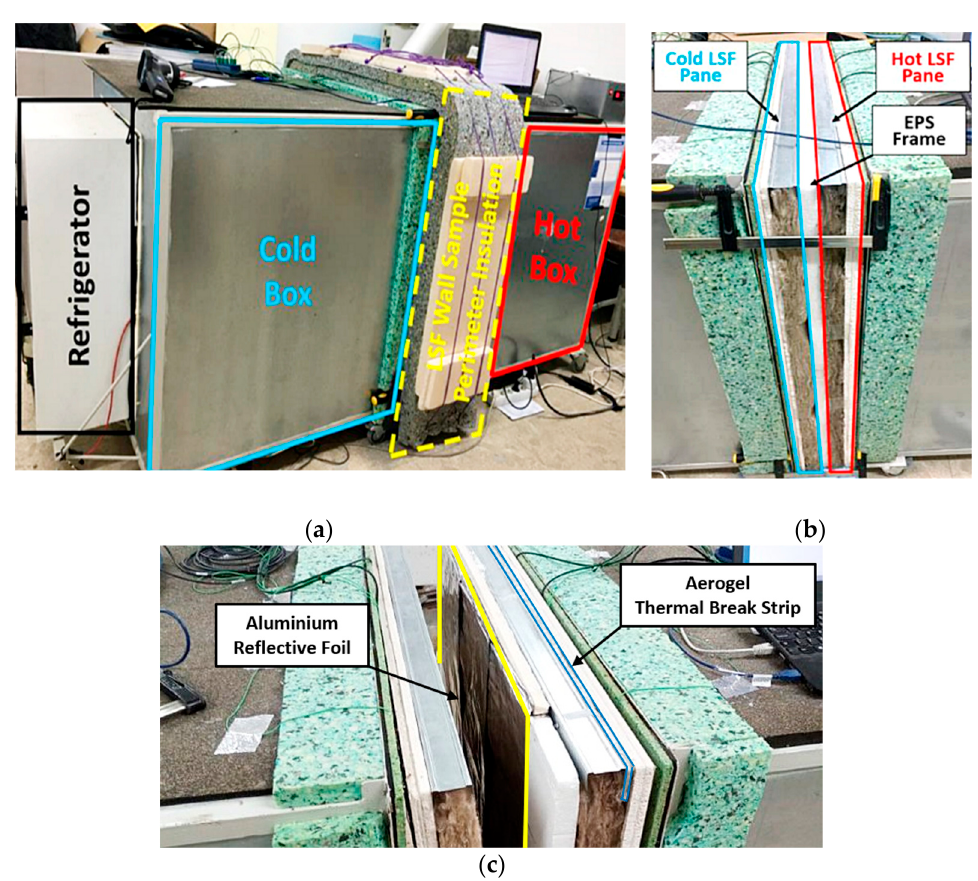
Figure 3. Mini hot box apparatus: ( a ) global view of the equipment; ( b ) LSF wall test sample; ( c ) LSF wall test sample with TB strips and a reflective foil.